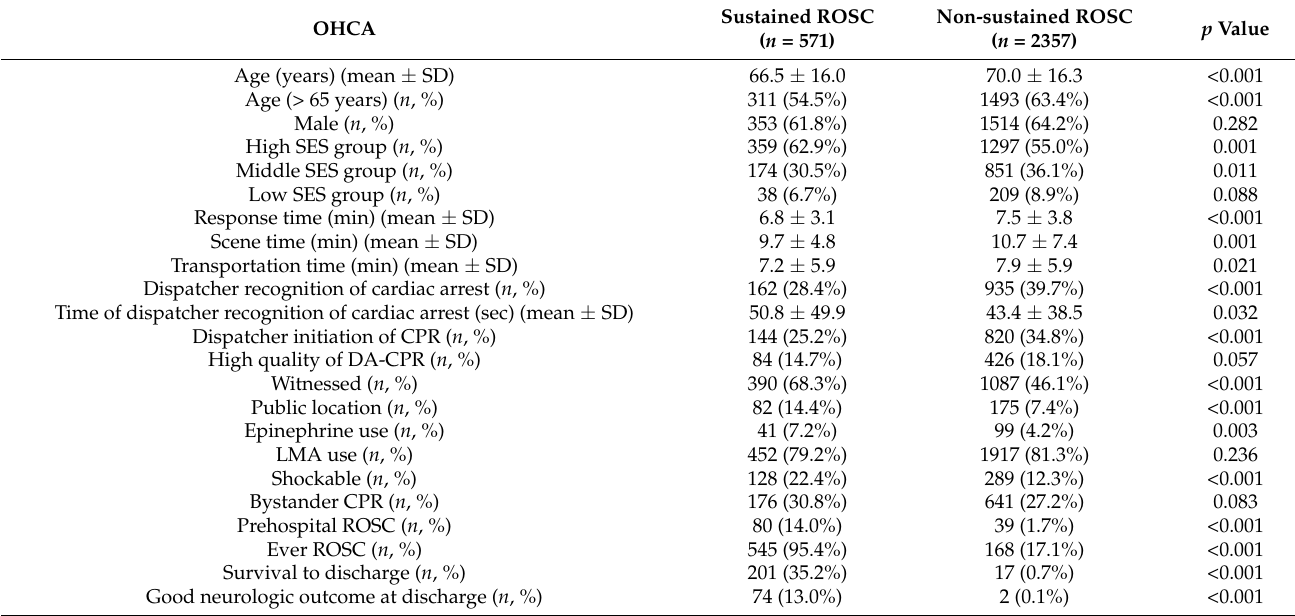
Table 3. Characteristics in patients with out-of-hospital cardiac arrest by achievement of a sustained ROSC or not. OHCA